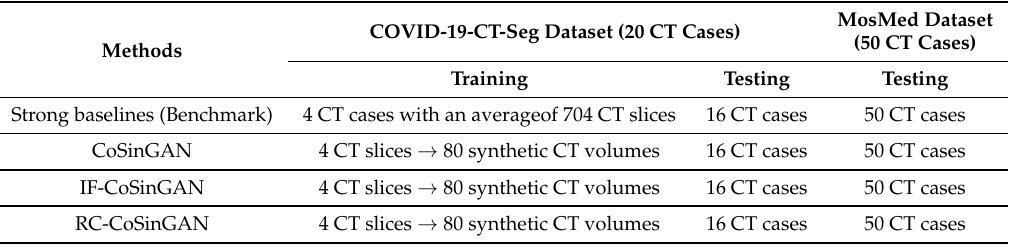
Table 2. Experiment settings of learning deep models with only COVID-19 CT scans (or slices) for automated lung and infection segmentation.